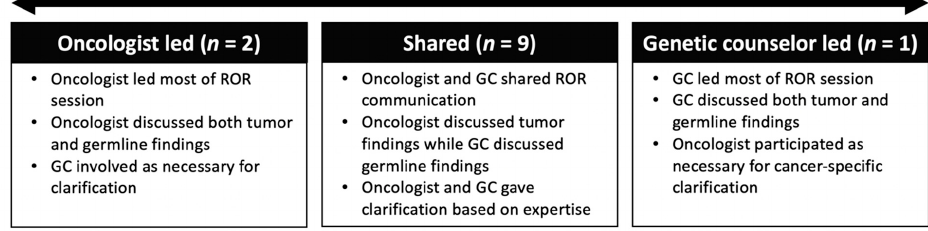
Figure 1. Collaboration between oncologists and genetic counselors during return of results.